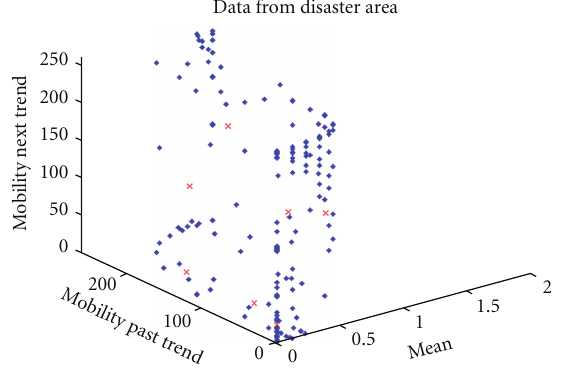
Figure 1: Clustering of data from DA scenario.